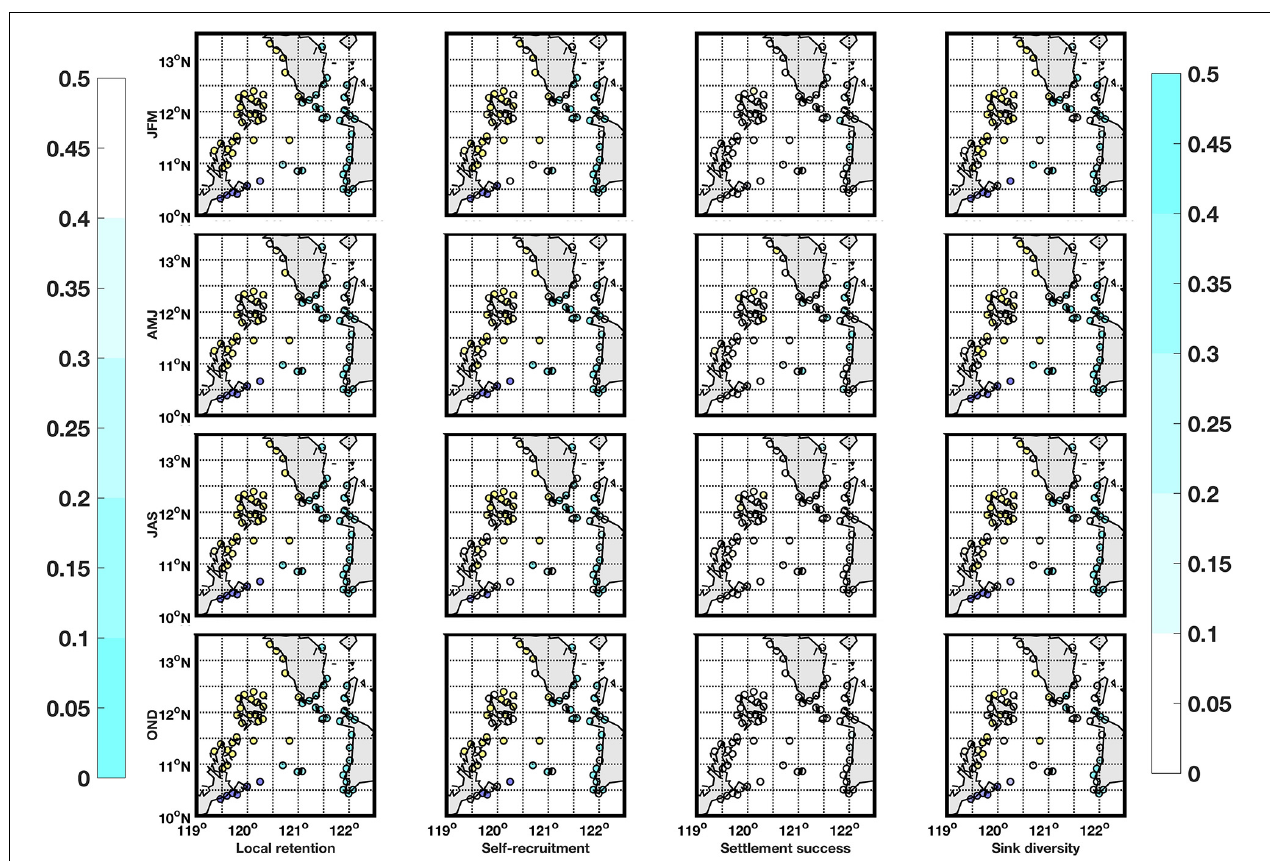
FIGURE 7 | Local retention (column 1) , self-recruitment (column 2) , settlement success (column 3) , and sink diversity (column 4) values for locations with suitable habitat for S. horrens species for the NEM (row 1) , dry-transition (row 2) , SWM (row 3) , and early NEM (row 4) . Locations are colored according to their marine province (Group 1 = purple, Group 2 = cyan, and Group 3 = yellow). Local retention and self-recruitment (settlement success and source diversity) values are shaded according to the representative colorbar on the left (right) and as such, possible priority locations are in darker shades for all